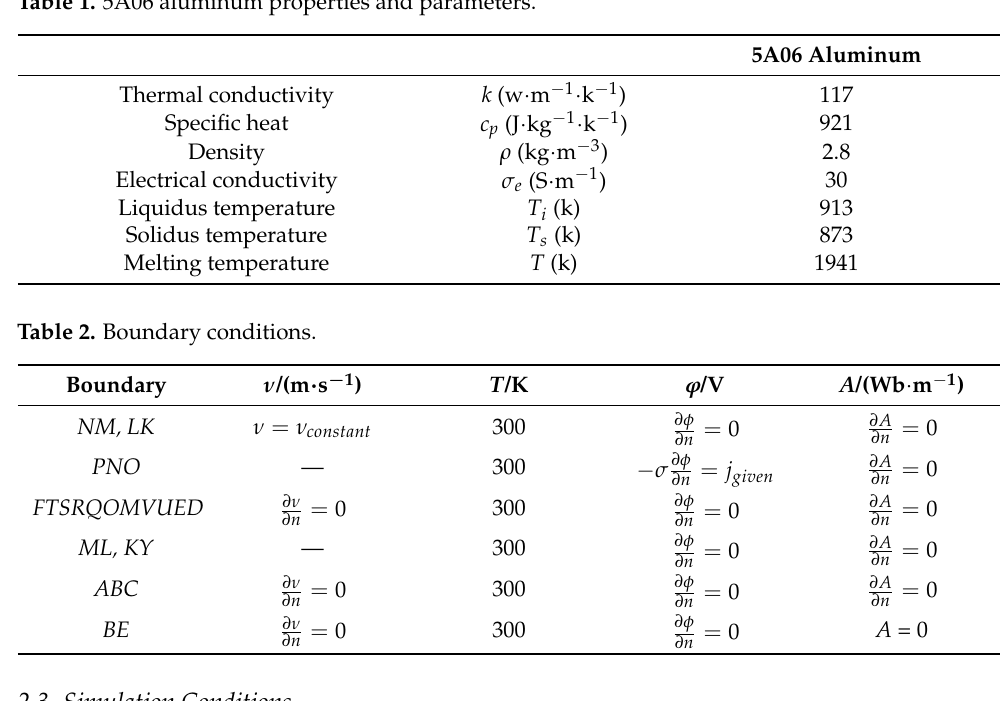
Table 1. 5A06 aluminum properties and parameters.